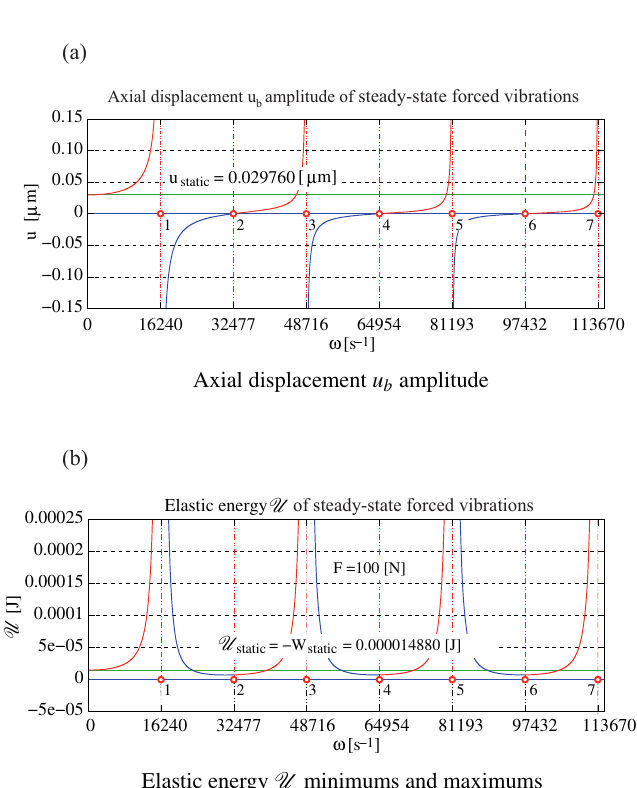
Fig. 8. Steady­state frequency response curves of fixed­fixed